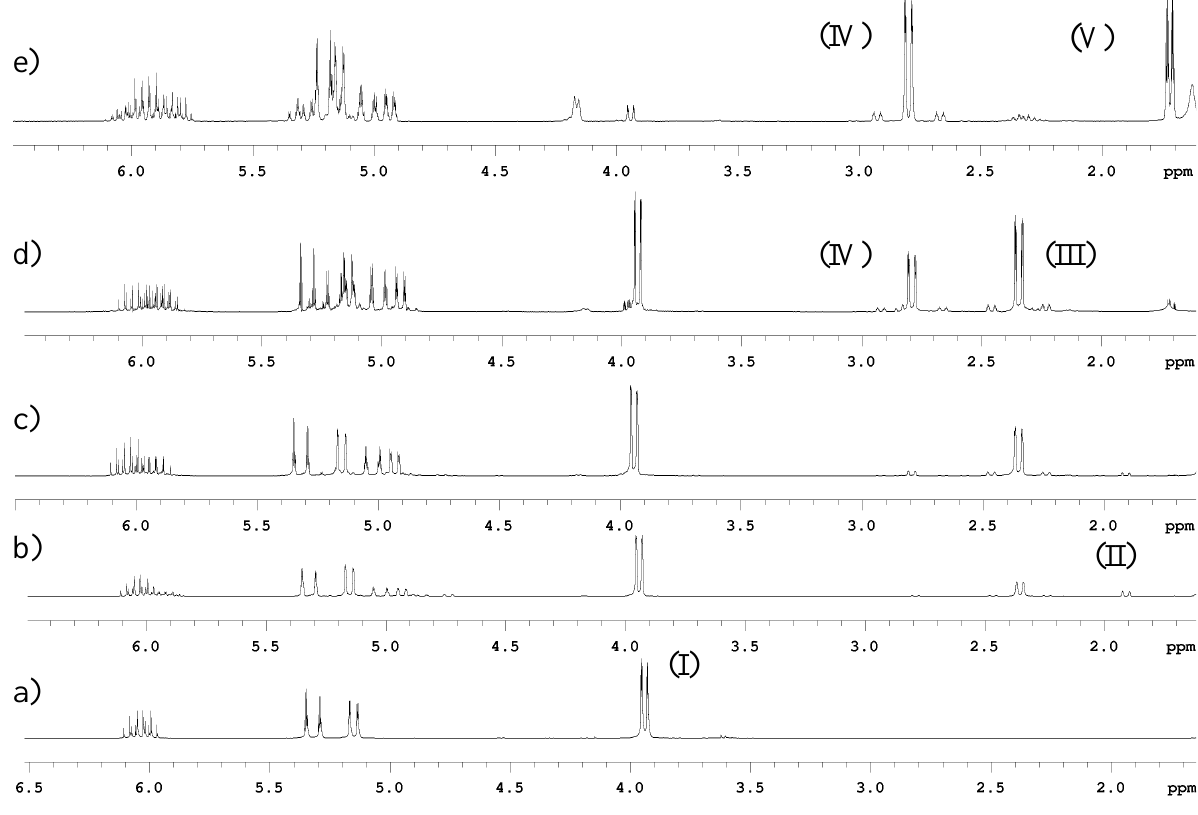
of the reaction of allyl bromide and tin in water after Figure 2. Partial 1 H-NMR spectra in CDCl 3 extraction. a) 15 minutes; b) 30 minutes; c) 1 h, d) 4 h and e) 8 h. Assignments: allyl bromide (I); tetrallyltin (II); triallyltin bromide (III); diallyltin dibromide (IV) and propene